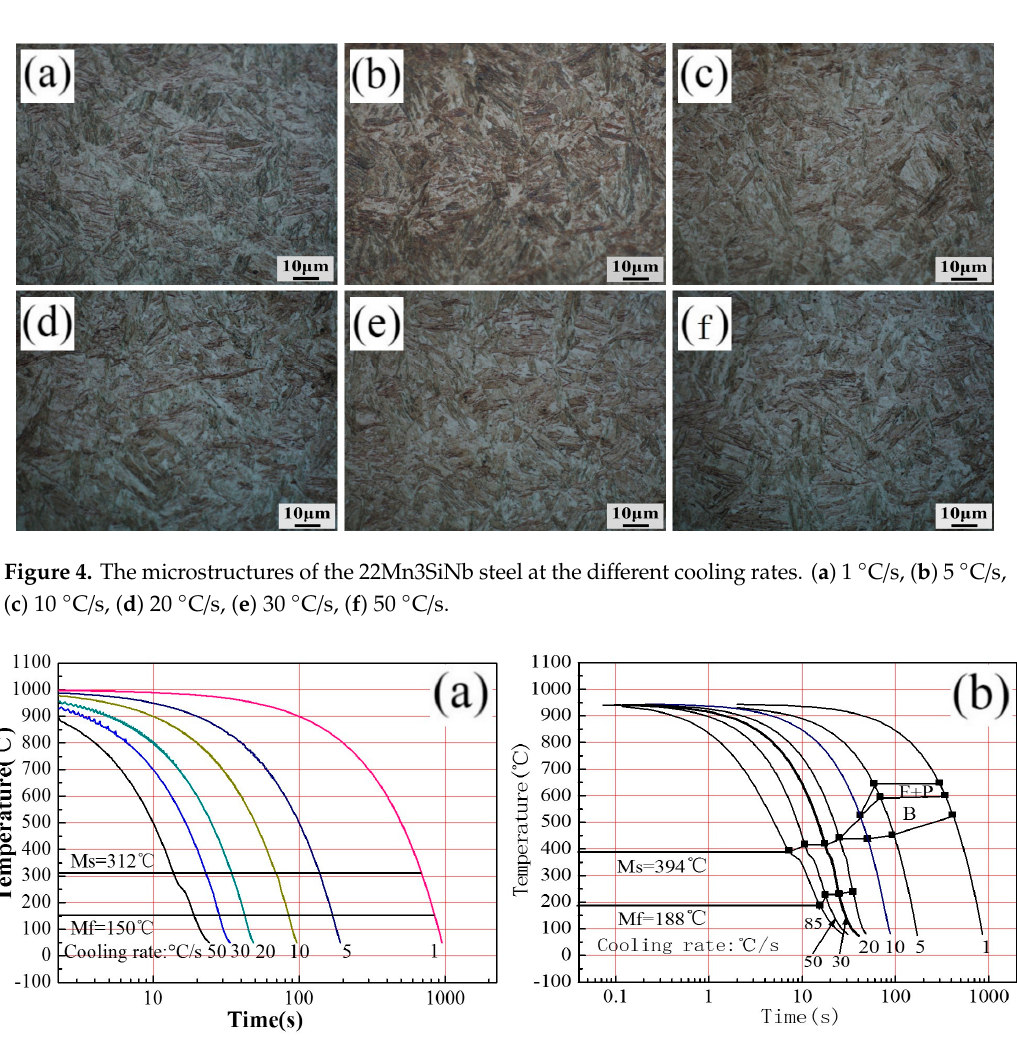
Figure 6. Engineering stress ‐ strain curves of samples before warm/hot stamping.